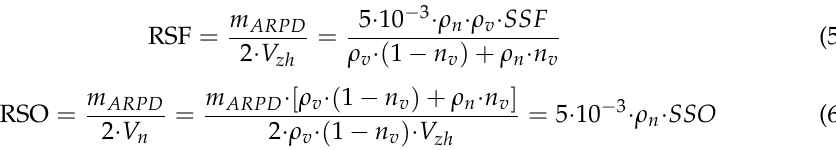
Table 4. RSF results of the laboratory investigation.